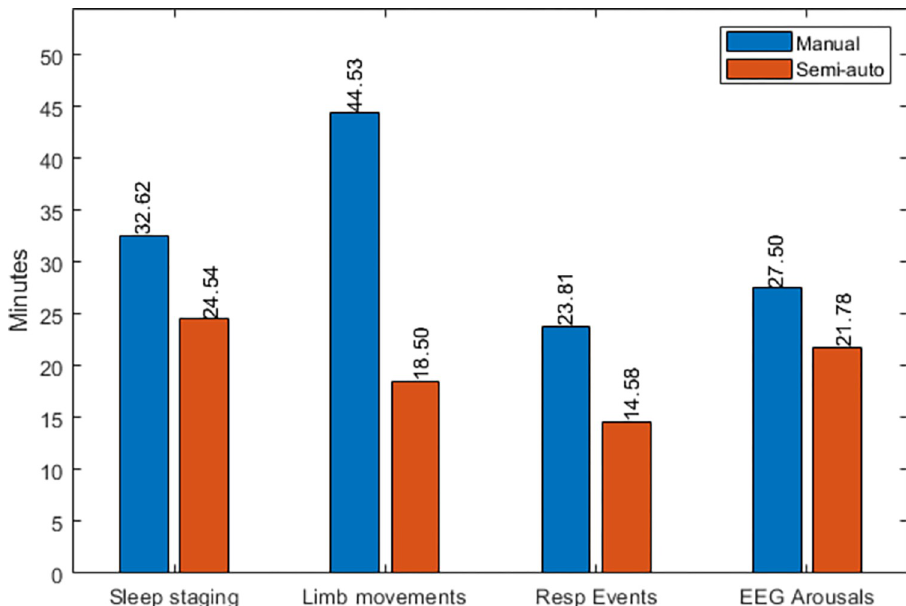
Fig 1. Differences in scoring time between manual and semi-automatic scoring approaches. Median scoring time per task is shown in minutes.